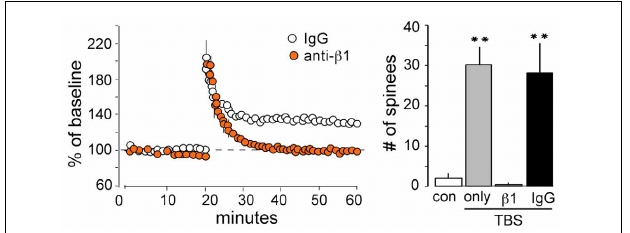
FIGURE 4 | ß1 integrins are required for TBS-induced LTP and increases in spine F-actin. Left : Plot shows that potentiation of the Schaffer-commissural projection to field CA1 is induced with TBS applied in the presence of the control anti-rat IgG but is blocked with local infusion of neutralizing antisera to ß1 integrin: note that with ß1 neutralization there is an initial post-TBS potentiation but the enhanced response rapidly declines to baseline indicating a failure in consolidation. Right : Quantification of spines containing dense F-actin in the CA1 field of afferent stimulation (from in situ phalloidin labeling). As shown, TBS elicits a large increase in spine F-actin if applied alone or in the presence of anti-rat IgG but this effect is totally blocked by neutralizing anti-ß1 ( ∗∗ p <